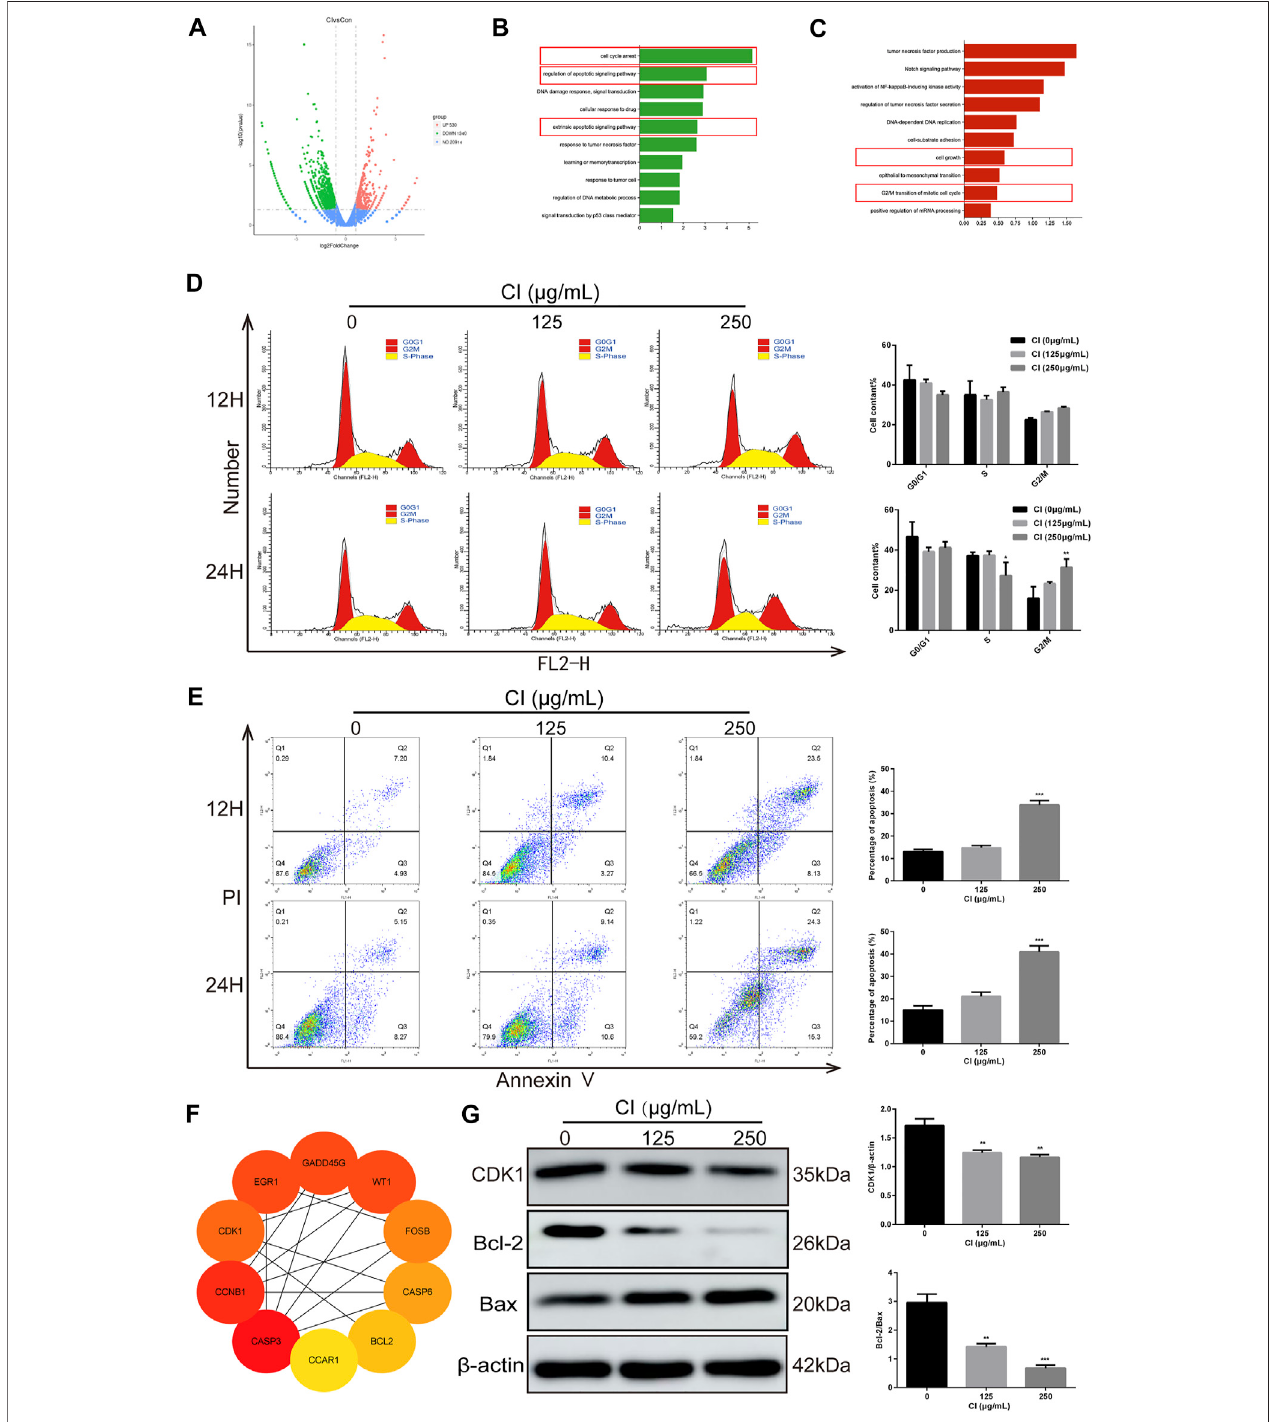
FIGURE 2 | Analysis of CI (125 μ g/ml)-regulated gene expression in MDA-MB-231 cells. (A) Upregulated and downregulated genes in MDA-MB-231 cells after CI treatment. (B) Genes generated from RNA-seq analysis that were annotated revealing key biological processes were upregulated. (C) Genes generated from RNA-seq analysis that were annotated revealing key biological processes were downregulated. (D) Cell cycle phases of MDA-MB-231 cell exposed to CI (0, 125, and 250 μ g/ml) for 12 and 24 h were analyzed by fl ow cytometry. The cell cycle phase distribution is indicated as mean ± SD ( n = 3). (E) Stained MDA-MB-231 cells exposed toCI (0,125,and250 μ g/ml)for12and24 h.Apoptoticcellproportionsareexpressed asmean±SD( n =3). (F) Top10genesrelated totumor,cellcycle,andapoptosis. (G) Levels of expression of CDK1, Bax, and Bcl-2 were determined using Western blot assessment. * p < 0.05, ** p < 0.01, *** p < 0.001 vs. control.